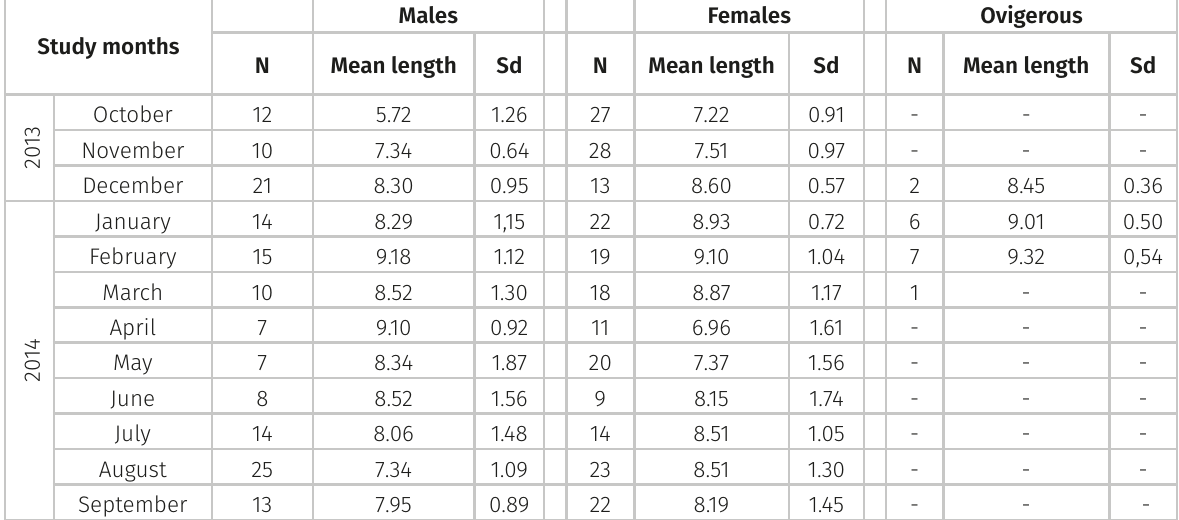
Table I . Monthly mean oval lengths (mm) of C. major specimens sampled at the Itararé Beach, São Vicente, state of São